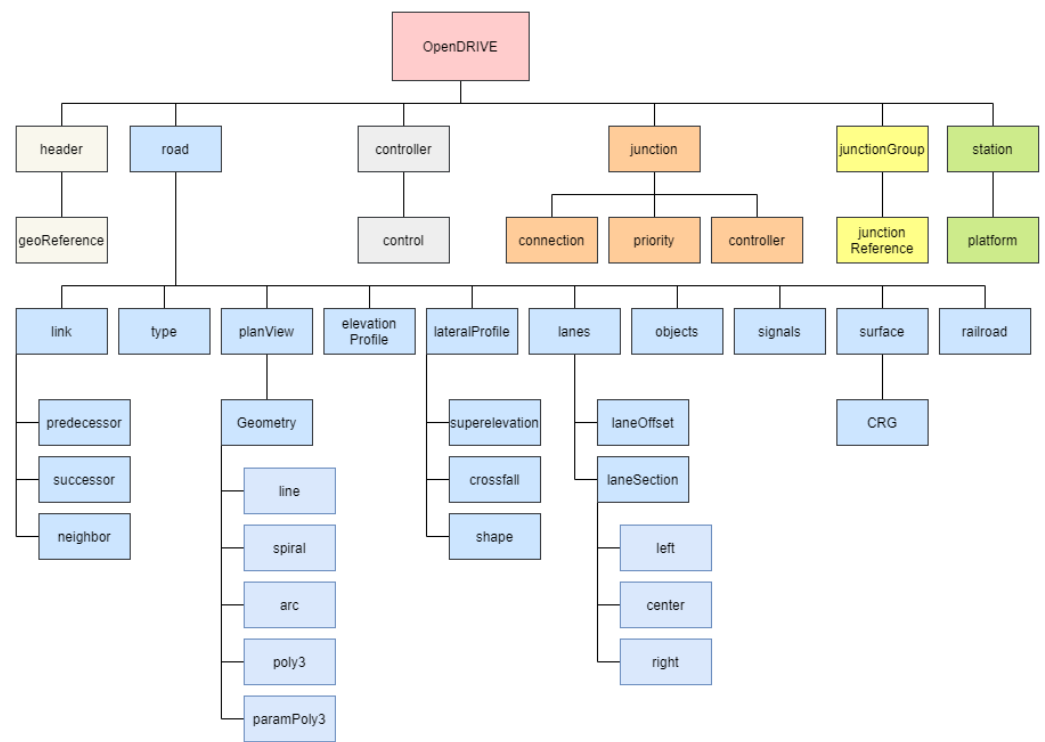
Figure 1. The bead structure of